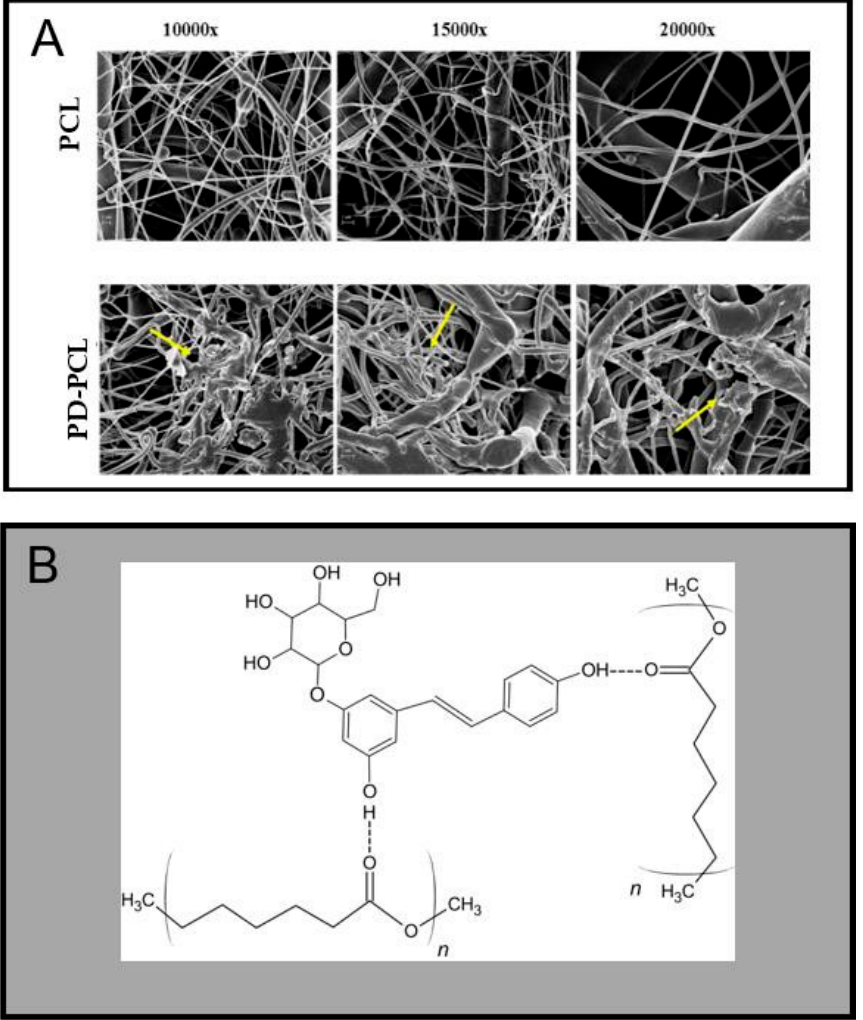
Figure 1. ( A ) Images of polycaprolactone (PCL) and polydatin-incorporated polycaprolactone (PD- PCL) nanofibers analyzed by scanning electron microscopy (SEM). ( B ) Schematic representation of the hypothetical hydrogen bonding interactions between PCL–PD copolymers.